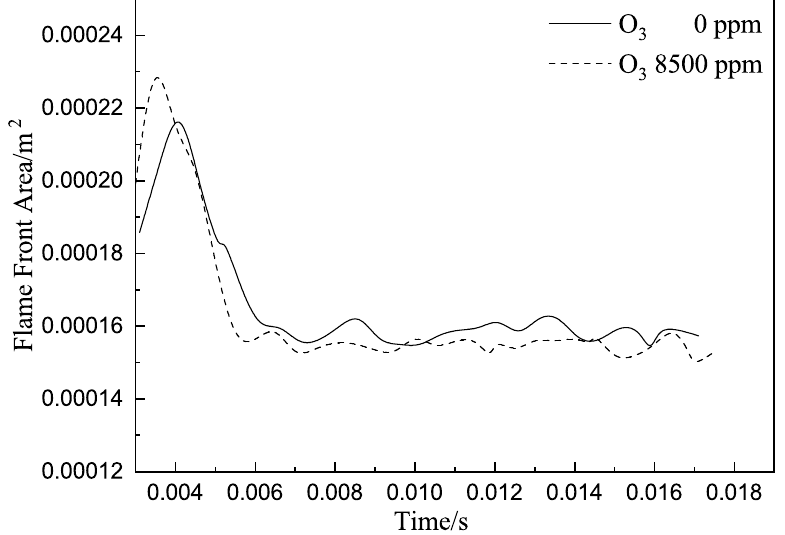
Figure 6. Variation curve of flame surface area with time at flame surface Y H